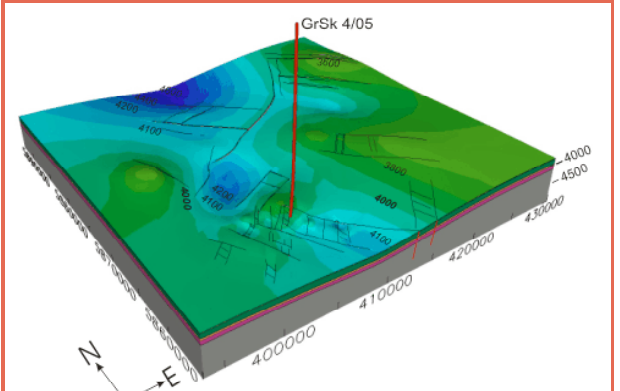
Figure 3. Structural 3-D map of the top of the reservoir rock (sandstones in the Lower Permian). The well is located at a structural high. The contour lines indicate the depth of top reservoir below sea